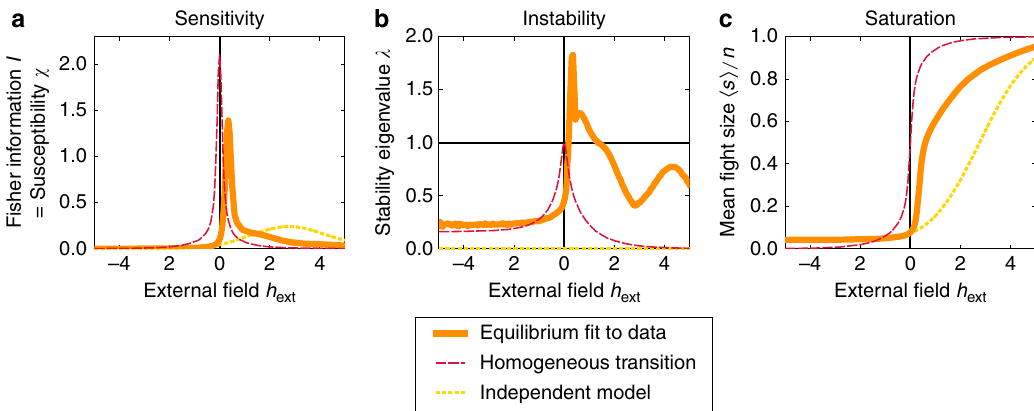
Figure 2 | The system is near a sensitive and unstable region of parameter space. ( a ) The susceptibility w , measuring the sensitivity of average fight size to an external perturbation, has a peak near the fit parameters (at h ext ¼ 0). The susceptibility is also equal to the Fisher information F ( h ext ), describing how quickly the distribution over fights becomes distinguishable as h ext is varied. ( b ) Instability of the lowest order mean-field solution is indicated by the eigenvalue l becoming larger than 1. Yellow dashed lines indicate a system of the same size with independent individuals, and red dashed lines indicate a homogeneous system of the same size tuned to be marginally unstable at h ext ¼ 0. ( c ) The transition is associated with large changes in mean fight